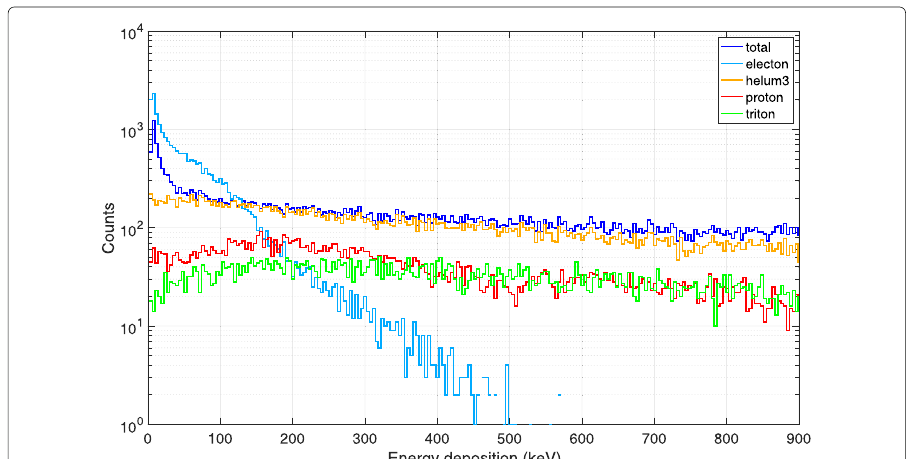
Fig. 4 Simulated energy deposition for the reaction products in configuration (FastN)